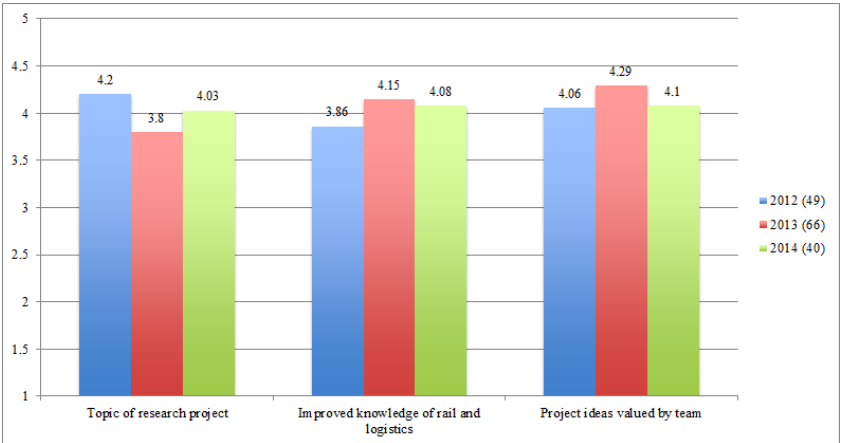
Figure 3. Mean rating of the personal experiences of the scientific aspects of Week